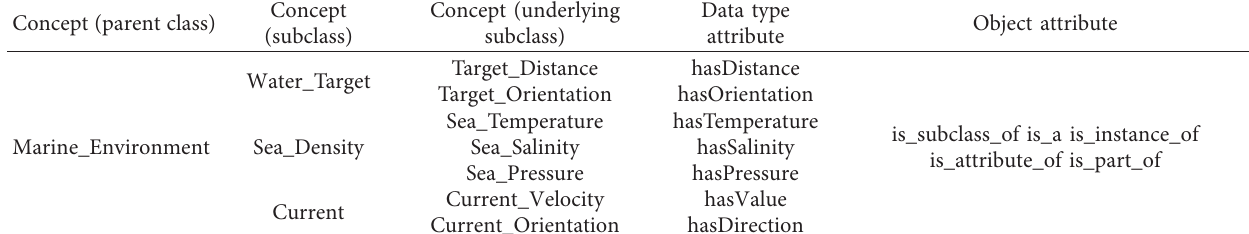
Table 2: Classes and attributes in the marine environment application